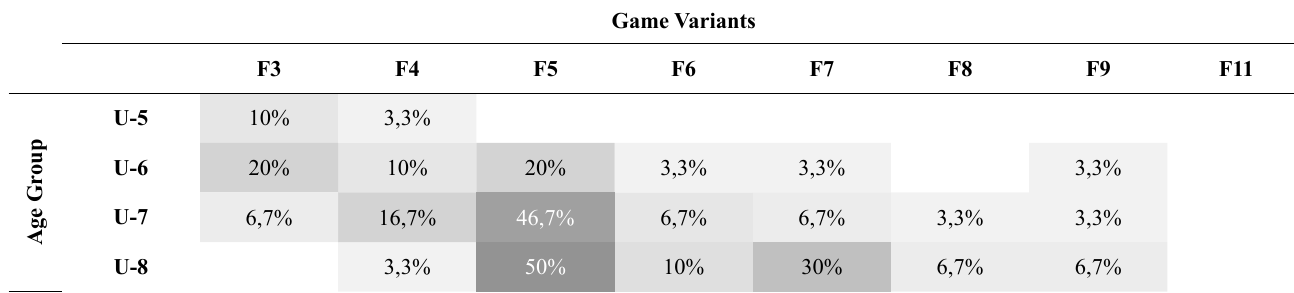
Table 3. Frequency of the game variants used across the different age groups of the youth